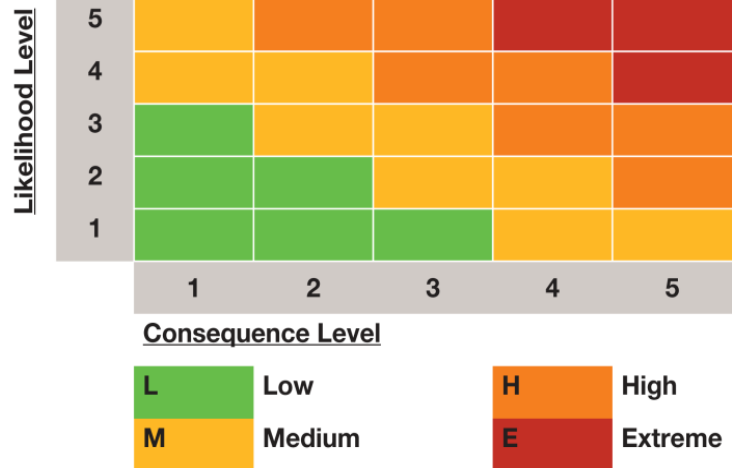
Figure 2. Generic risk